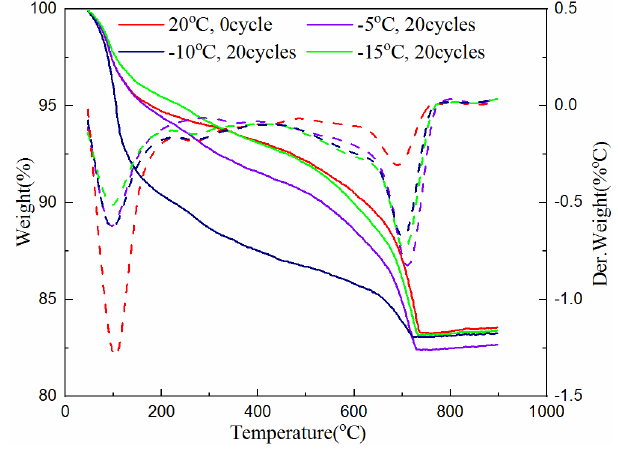
Figure 6. Hydration product of samples at different freezing temperatures after 28-day curing.